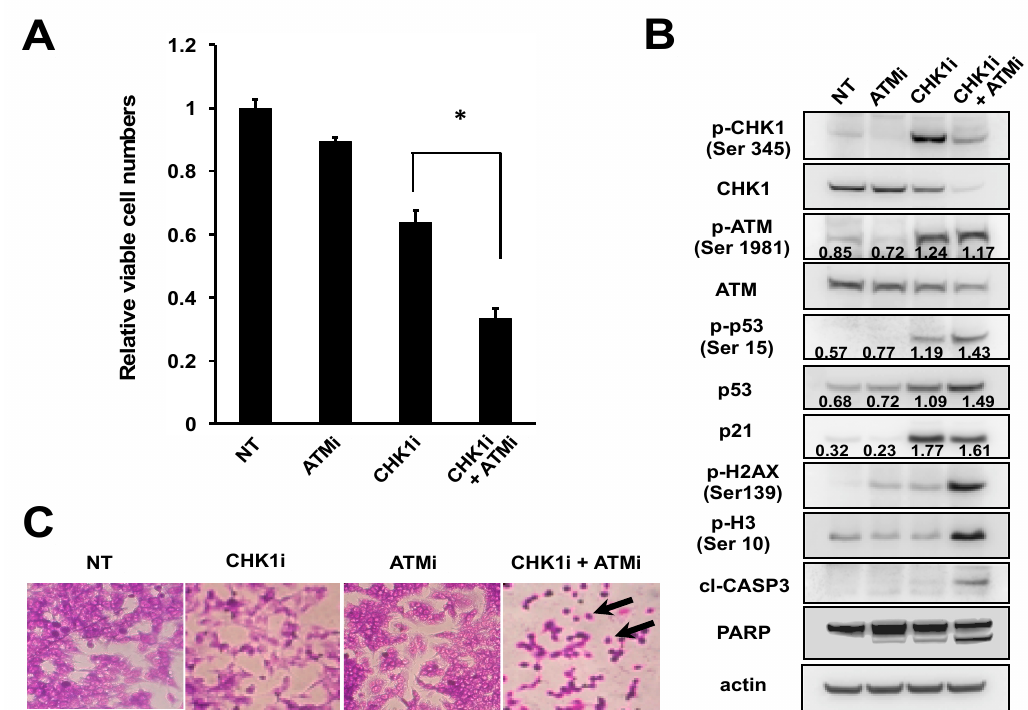
Figure 4. Combination treatment with CHK1 and ATM inhibitors induces NB-39-nu cell death. (A–C) NB-39-nu cells were treated with DMSO (NT), 0.175 µM PF-477736 (CHK1i), 10 µM Ku55933 (ATMi), or 0.175 µM PF-477736 plus 10 µM Ku55933 (CHK1i + ATMi). Cells were then harvested and analyzed for ( A ) alamarBlue cell viability assay, ( B ) protein expression by immunoblotting at 7 days after indicated treatments, or ( C ) Giemsa staining and microscopy at 6 days after indicated treatments. In (A), the graphs were plotted using the values from four independent experiments. Data are presented as the mean ± SD. * p < 0.05. cl-CASP3, cleaved caspase-3; PARP, poly (ADP-ribose) polymerase. In (B), Representative numbers were normalized to the intensity of the indicated bands. In C, black arrows indicate the examples of cell shrinkage with disruption of cell–cell